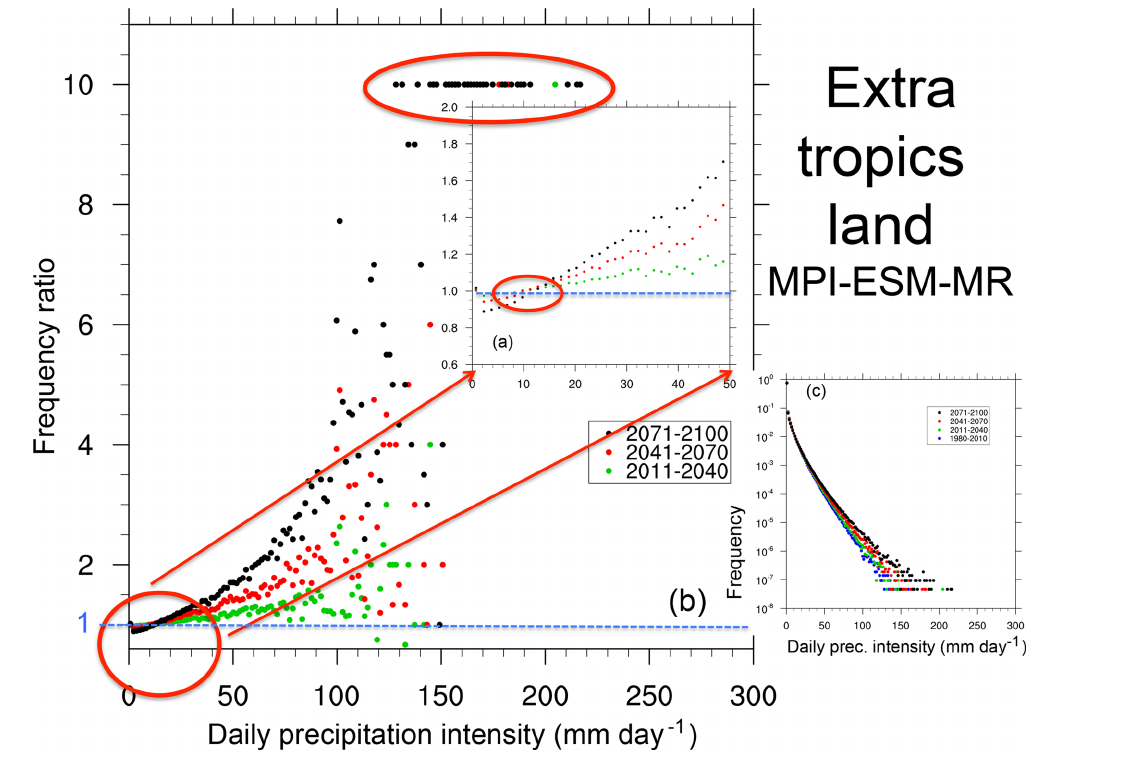
Figure 4. Same as Fig. 3 but for extratropical land